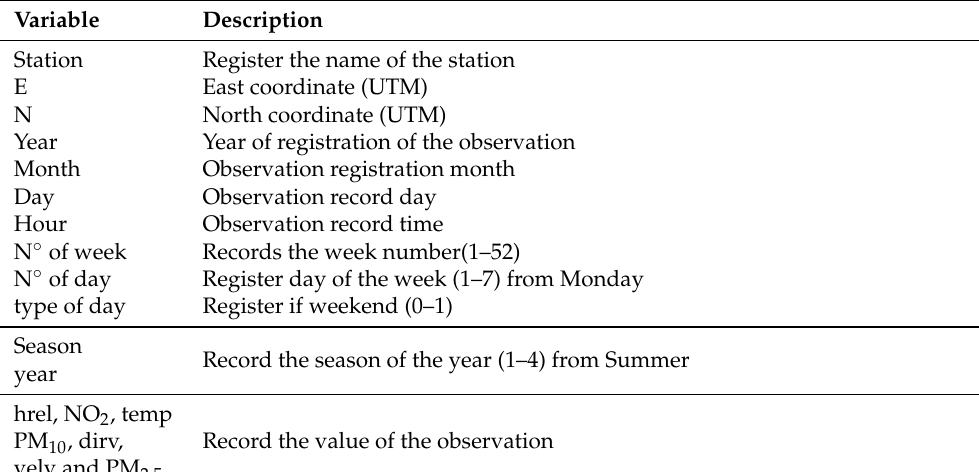
Table 2. Description of the columns once the first pre-processing step was carried